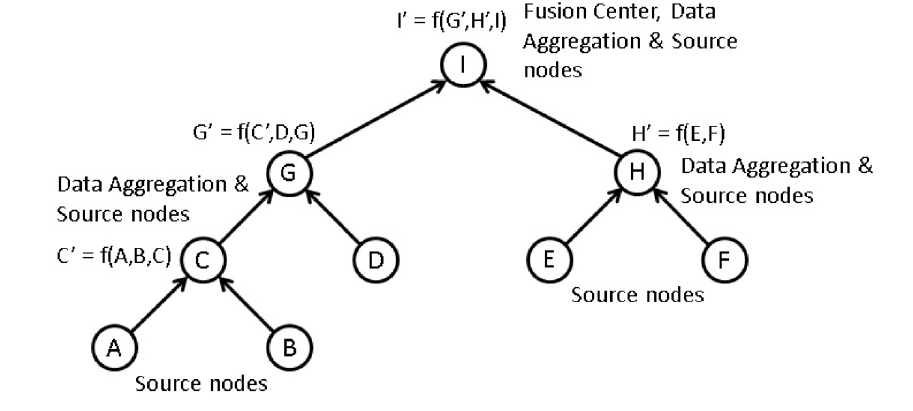
Figure 2. Binary tree-based network topology using data gathering with information fusion function f ( .. )